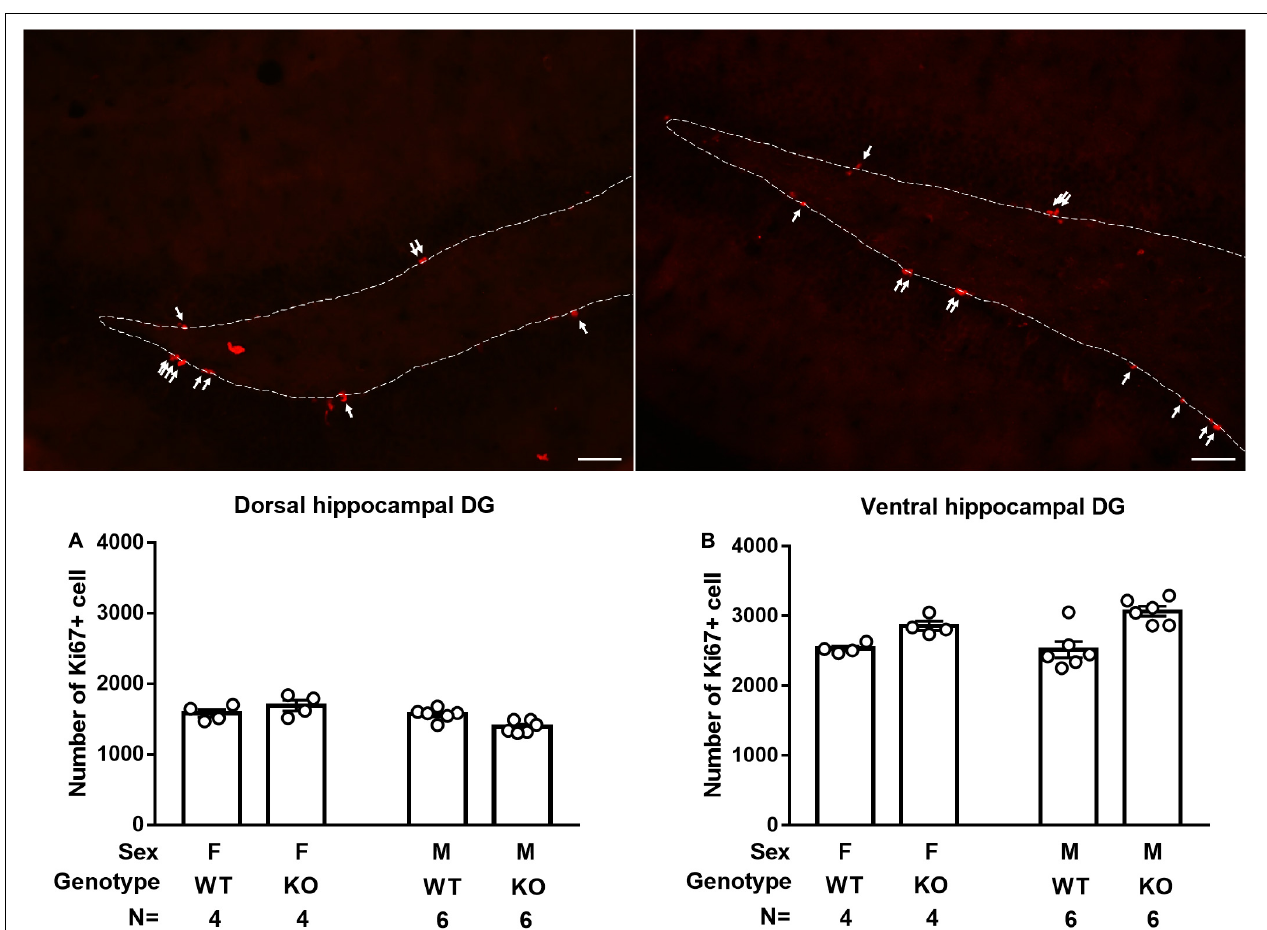
FIGURE 5 | Dorsal and ventral hippocampal cell proliferation in WT and SEPT14 KO mice. Microphotograph representatives of dorsal (top left) and ventral (top right) DG with white arrows pointing to Ki67-positive cells. (A) Male and female SEPT14 KO mice had comparable numbers of newly proliferated cells in dorsal hippocampal DG. (B) SEPT14 KO mice had greater newly proliferated cells as compared with their same-sex WT mice in ventral hippocampal DG [ F (1,12) = 21.43, p = 0.0006]. The bar and error bar represent group mean and SEM,